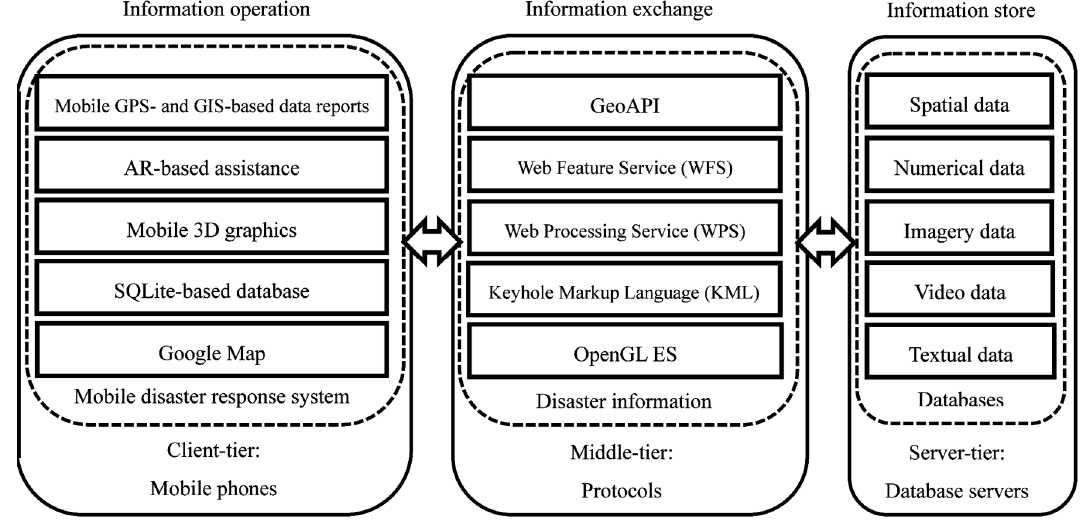
Fig. 3. Three-tier System framework